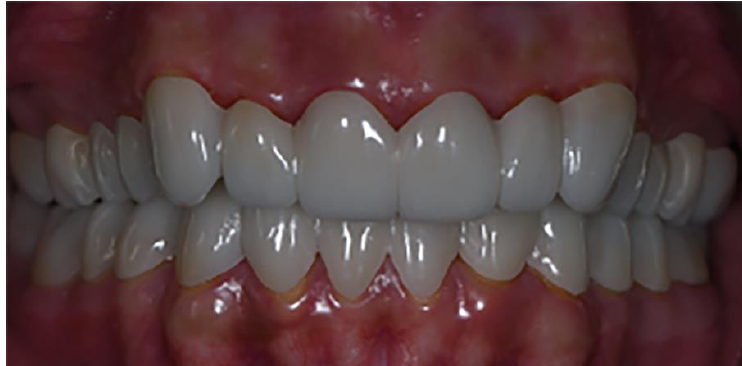
Prosthesis 2022 , 4 , FOR PEER REVIEW Figure 8. Case 3—Digital project of the upper and lower dental arches. Figure 8. Case 3—Digital project of the upper and lower dental arches.